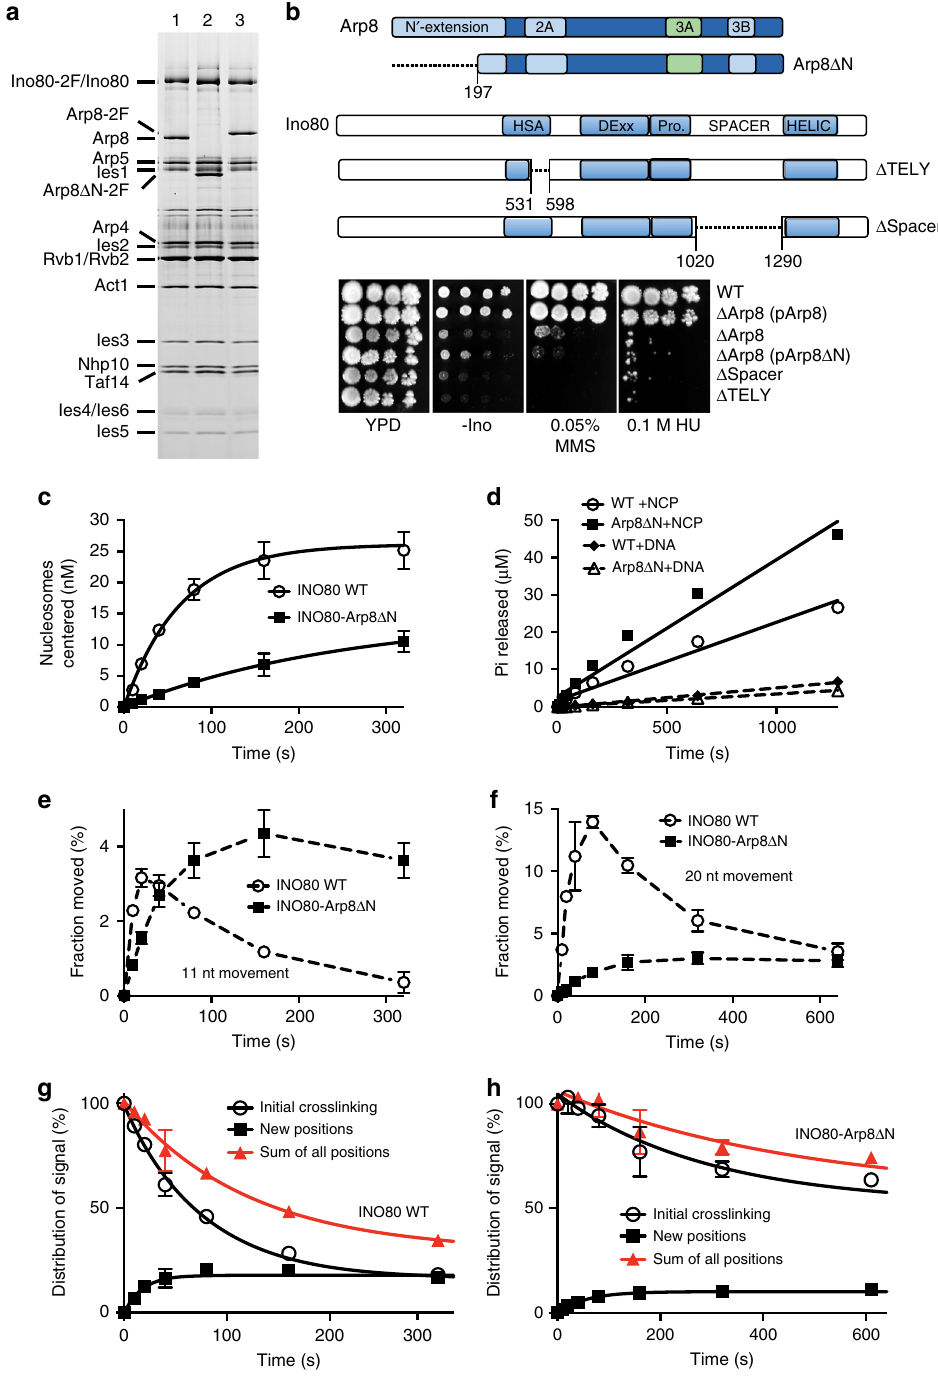
Fig. 2 The N-terminus of Arp8 is required for the in vivo and nucleosome mobilization activities of INO80. a Complex integrity is maintained in puri fi ed wild-type INO80 with Ino80-2FLAG (lane 1), INO80-Arp8 Δ N with 2FLAG-Arp8 Δ N (lane 2), and INO80 with 2FLAG-Arp8 (lane 3). b Top panel: Schematic depicting deleted regions in Arp8 (Arp8 Δ N) and Ino80 ( Δ TELY and Δ Spacer) mutants. Plasmids expressing wild type or mutant Arp8 (Arp8 Δ N) were introduced into arp8 null yeast and compared to strains lacking INO80 function ( Δ Spacer and Δ TELY). c Plots showing the rates at which wild type and Arp8 Δ N INO80 move 70N0 nucleosomes (representative native electrophoretic mobility shift assay (EMSA) images shown in Supplementary Fig. 3a). d Plots based on thin-layer chromatography data showing the rates of ATP hydrolysis of wild type and Arp8 Δ N INO80 in the presence of either nucleosomes or naked DNA assayed in the same conditions as in c . e , f DNA movement on the histone octamer surface of nucleosomes was measured using nucleosomes modi fi ed at residue 53 of H2B (see Supplementary Fig. 3c). Plots show the fraction of nucleosomes that moved 11 ( e ) and 20 ( f ) base pairs from the starting position versus time by wild type and Arp8 Δ N INO80. g , h The amount of DNA cleaved at the starting position (initial crosslinking), the total amount of cleaved DNA that accumulates during remodeling (new positions), and sum of the intensities of the initial and remodeled positions (sum of all positions) track the retention of histone-DNA contacts versus time for wild type ( g ) and Arp8 Δ N INO80 ( h ). Error bars in c – h denote s.e.m. from ≥ 3